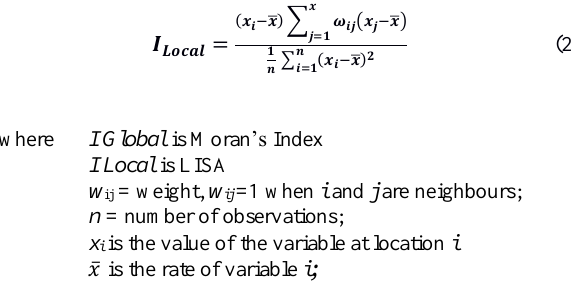
Figure 5. Local spatial autocorrelation of average prices in neighborhoods of Salvador.